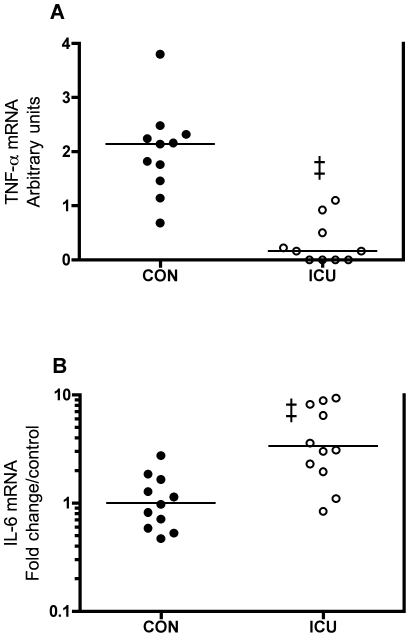
Lower TNF-α and higher IL-6 mRNA expression in muscle of critically ill patients.TNF-α (A) and IL-6 (B) mRNA expression in thigh skeletal muscle of critically ill intensive care unit (ICU) patients compared with controls (CON). As TNF-α mRNA was below the detection limit in some ICU patients (yielding 0 values), TNF-α mRNA was determined in quadruplicate and the median values for each group are reported in arbitrary units. IL-6 data are fold change in individual values relative to control mean. Each circle represents one subject (black: controls, white: ICU patients) and the bar represents the median TNF-α or the mean IL-6 value. ‡ p<0.001, Mann-Whitney U test for TNF-α and Welch's t-test for IL-6.